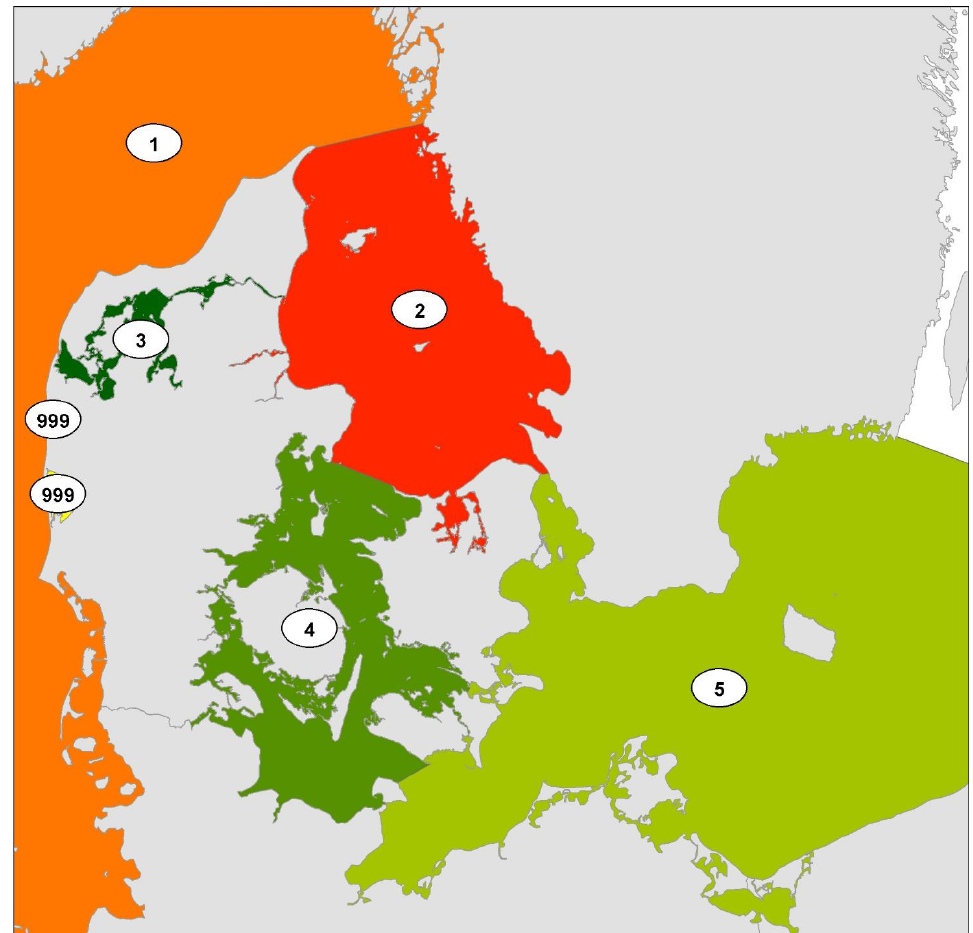
Figure 1. Map of Danish marine waters. Sub-regions are indicated in different colors: (1) the North Sea and Skagerrak; (2) Kattegat; (3) the Limfjord; (4) the Belt Sea; and (5) the Baltic Sea. The two areas labeled 999 are Nissum Fjord and Ringkøbing Fjord. Both have been included in sub-region 1 in this study.